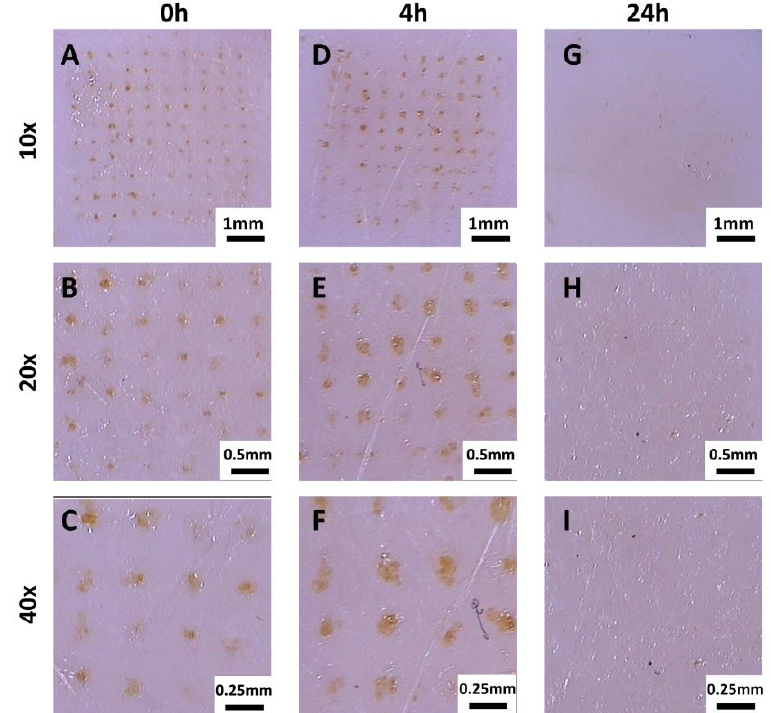
Figure 2. Dermoscopic images of porcine skin treated with PRN-loaded MN measured at different magnifications. ( A – C ) Dermoscopic images obtained immediately after topical application of PRN-loaded MN. ( D – F ) Dermoscopic images obtained 4 h after topical application of PRN-Loaded MN. ( G – I ) Dermoscopic images obtained 24 h after topical application of PRN-loaded MN.